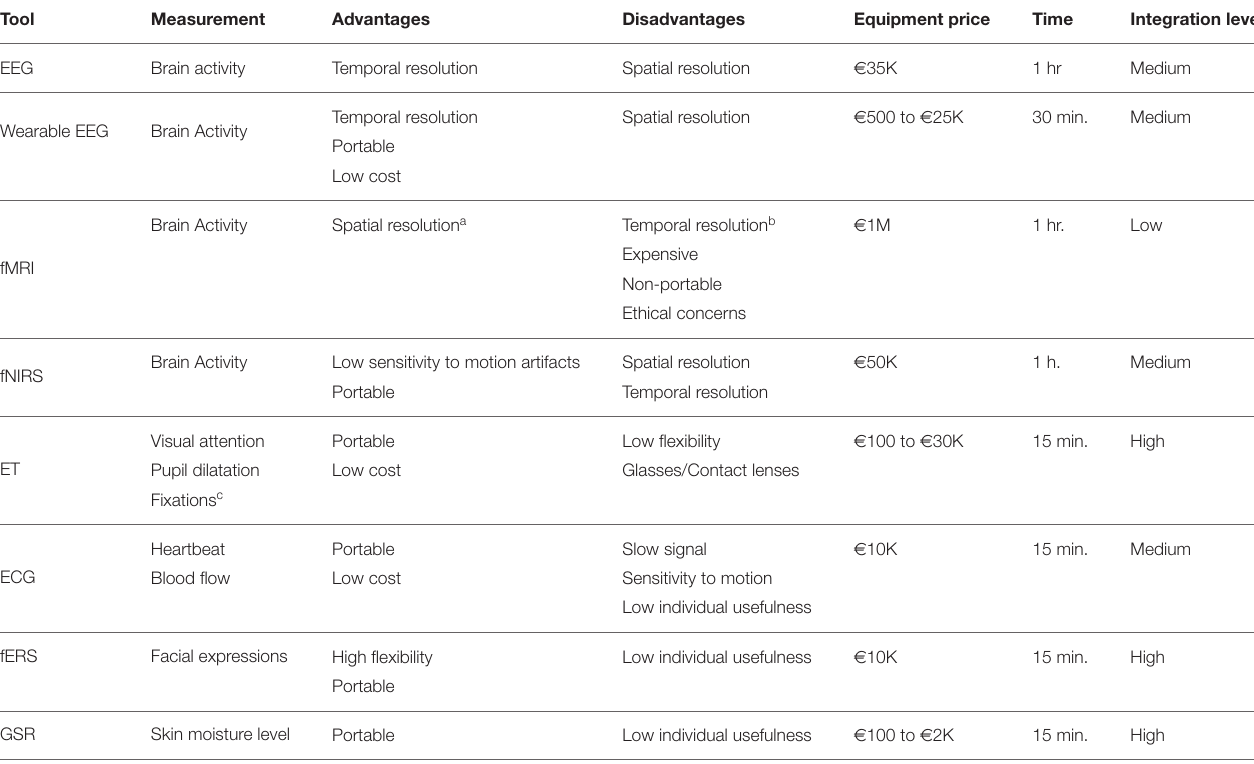
TABLE 2 | Characteristics of Consumer neuroscience